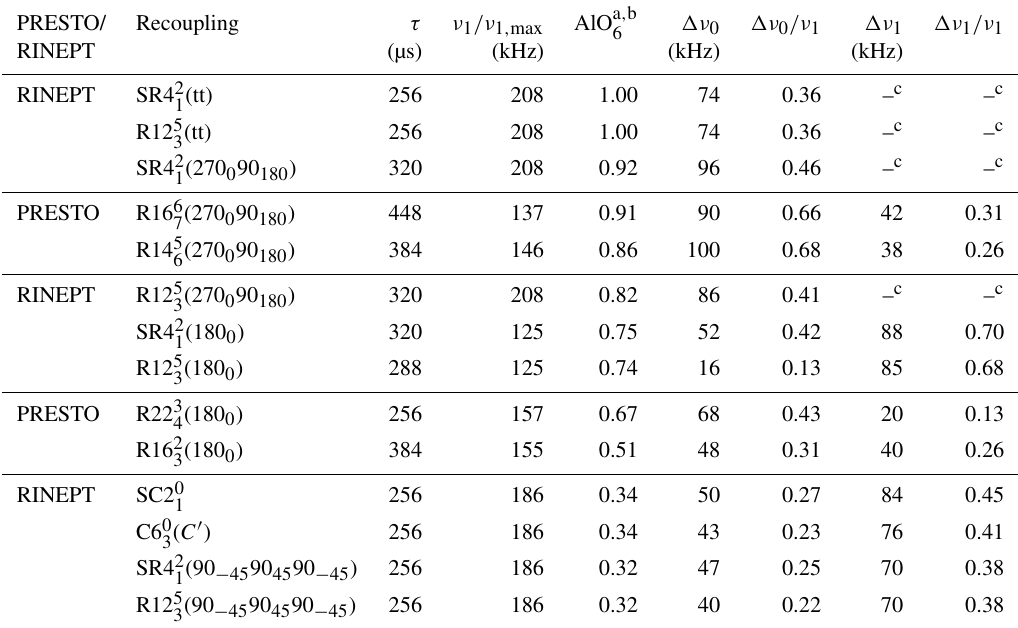
Table 3. Comparison of the performances of 1 H → 27 Al RINEPT-CWc and PRESTO transfers using various recouplings for the AlO 6 signal of γ -alumina at ν R = 62 . 5kHz. PRESTO/ Recoupling